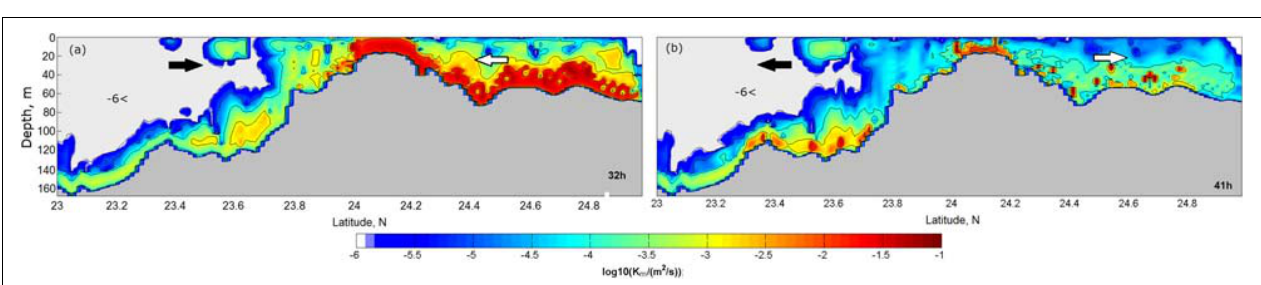
FIGURE 8 | Vertical turbulent diffusivity, K m , along the meridional section MS1 at peak velocity on (a) the flood and (b) on the ebb. Arrows show the direction of the flow during the flood and ebb